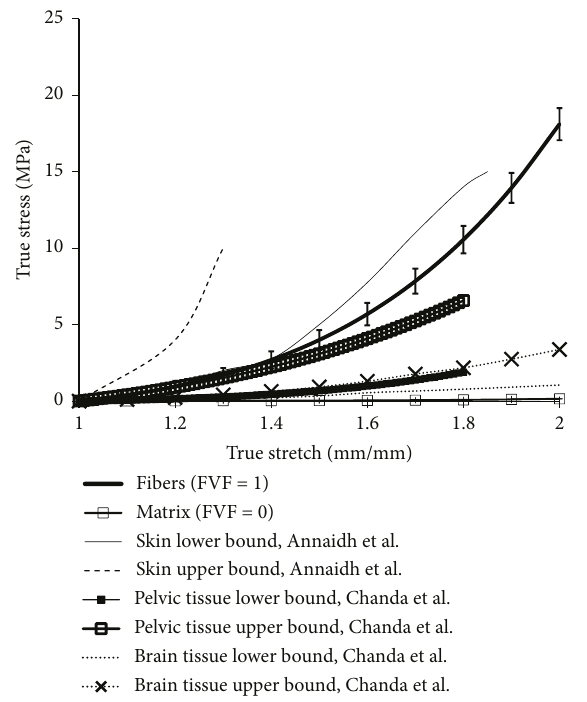
Figure 7: Comparison of the range of soft composite material properties with that of the human skin [12], pelvic [20], and brain tissues